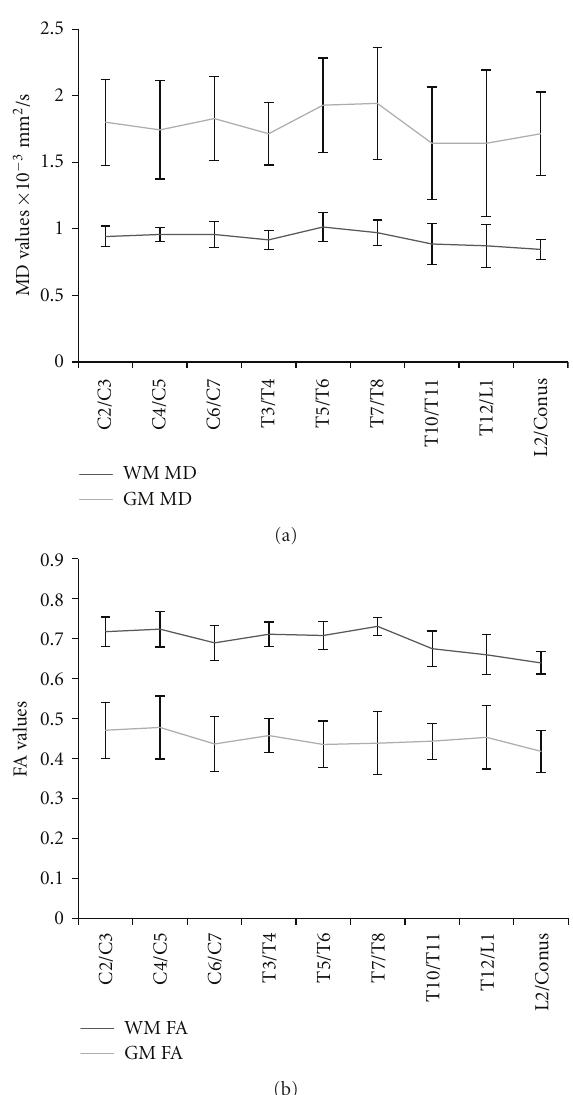
Figure 3: (a) MD values from the white matter and grey matter cluster averaged across subjects for each segment of the cord. (b) White matter and grey matter FA values averaged across subjects for each segment of the